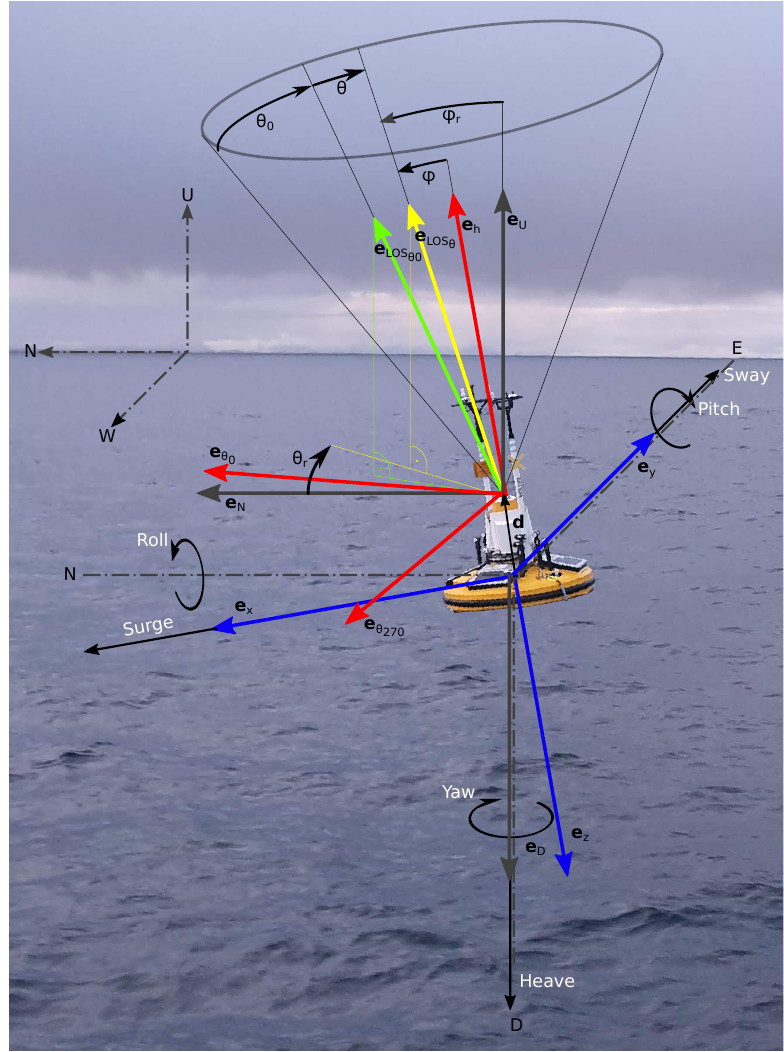
Figure 1. Visualization of the SEAWATCH Wind LiDAR Buoy in pitched orientation. Shown are the global right-handed North-West-Up (NWU) coordinate system and the north-east-down (NED) reference frame of the motion reference unit (MRU) (gray); unit vectors (cid:126) e x , (cid:126) e y , and (cid:126) e z along the rotated body coordinate axes of the (MRU) (blue); unit vectors (cid:126) e θ , (cid:126) e θ , and (cid:126) e h defining the lidar frame of 0 270 reference (red); the line-of-sight (LOS) unit vector (cid:126) e LOS for the azimuth offset angle θ 0 (green); and the θ 0 LOS unit vector (cid:126) e LOS for an arbitrary θ (yellow). Additionally, the separation vector (cid:126) d between the θ MRU and lidar prism is shown, as are the nominal and real azimuth ( θ and θ r ) and zenith angles ( φ and φ r ). (Sketch not to